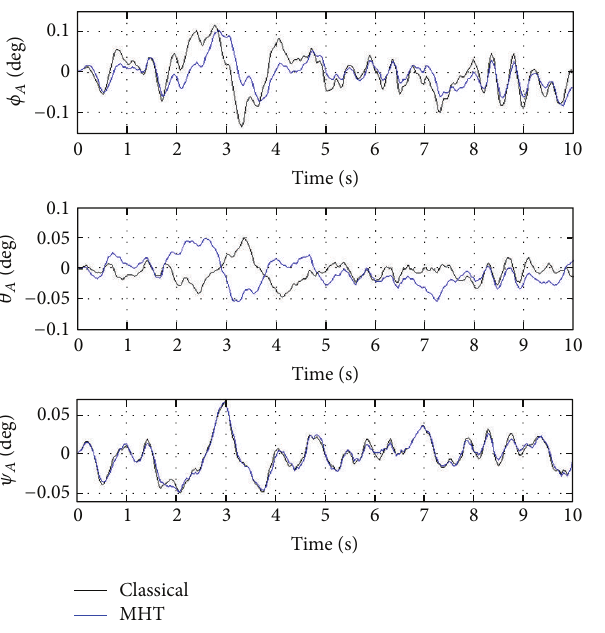
Figure 5: Responses of helicopter Euler angle states.